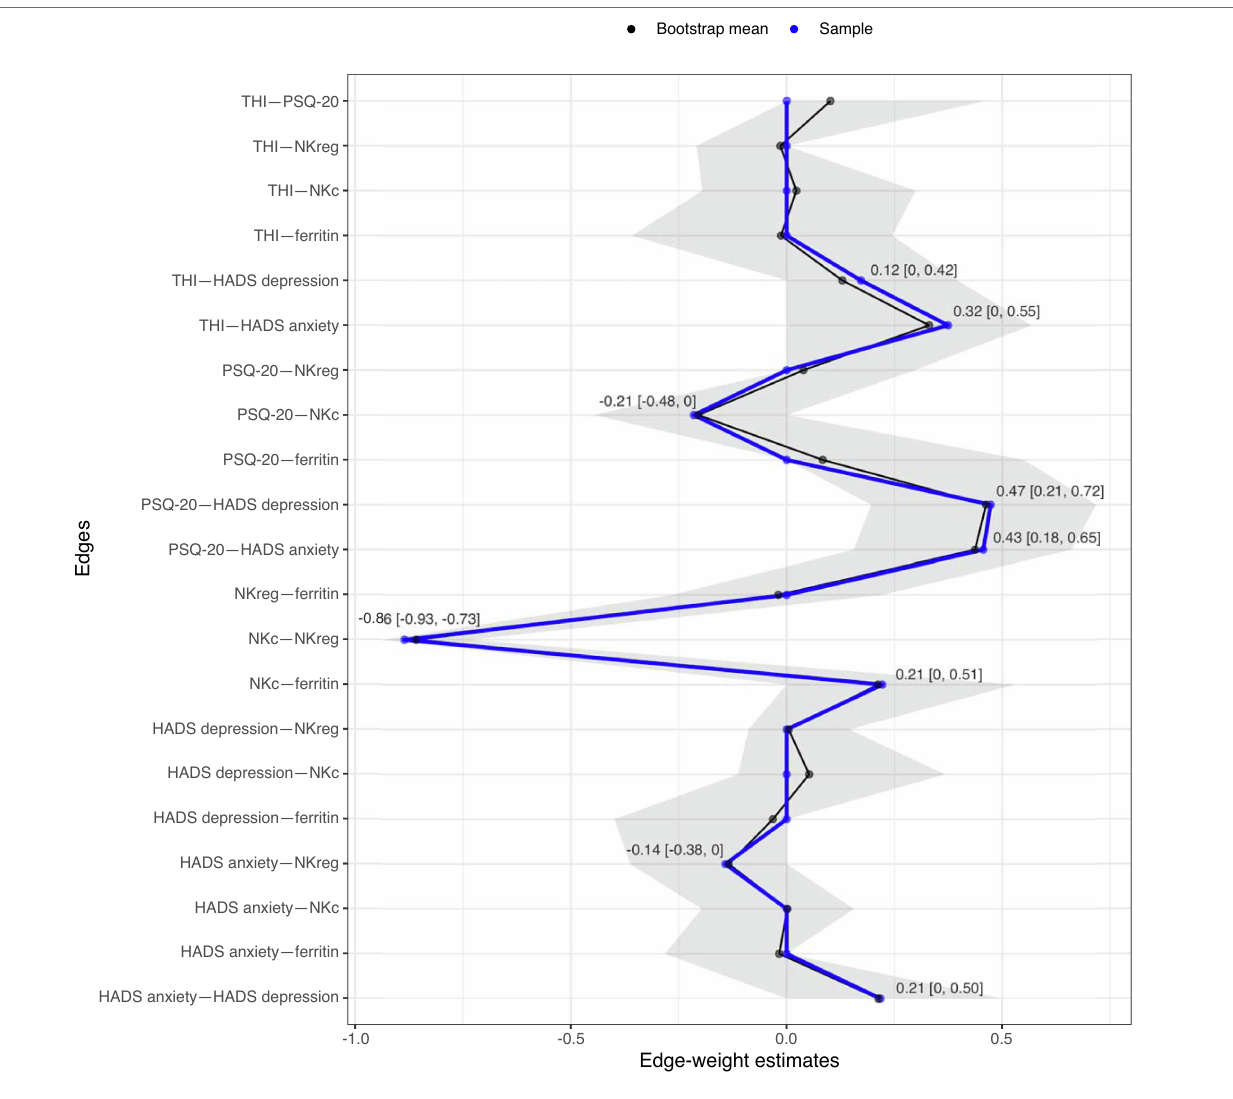
FIGURE 4 | Estimated edge weights in the sample (blue line) and bootstrapped mean (black line) over 1,000 bootstrapped networks; grey area shows bootstrapped 95%-confidence intervals (CIs). Numbers in the plot indicate the bootstrapped mean [95%-CIs] for all edges observed in the original network. Network estimation was based on averaged variable values across all repeated measurement sessions (baseline, 7.8-week follow-up, 13.8-week follow-up). HADS, Hospital Anxiety and Depression Scale; NKc, Cytotoxic Natural Killer Cells; NKreg, Regulatory Natural Killer Cells; PSQ-20, Perceived Stress Questionnaire (20-item version); THI, Tinnitus Handicap